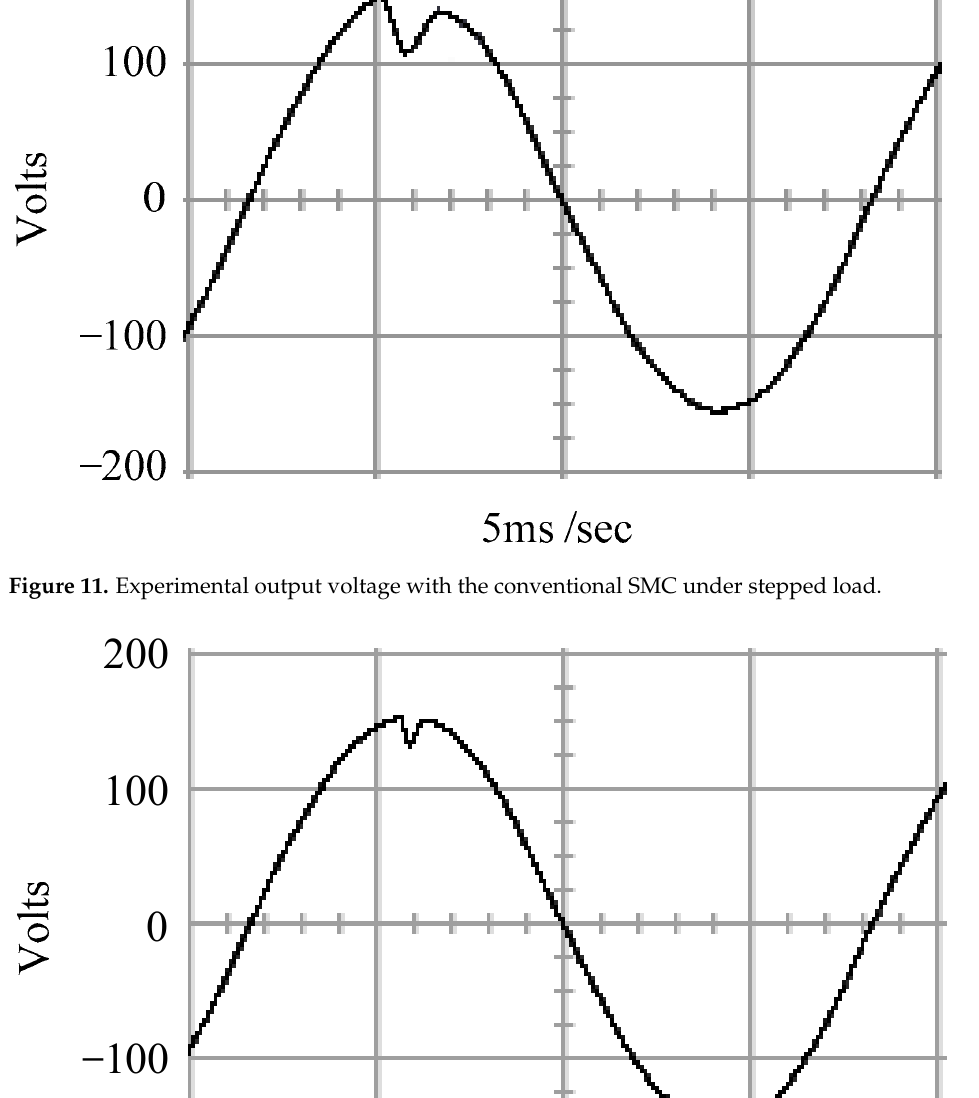
Figure 13. Experimental output voltage with the conventional SMC under LC parametric varia- tions.